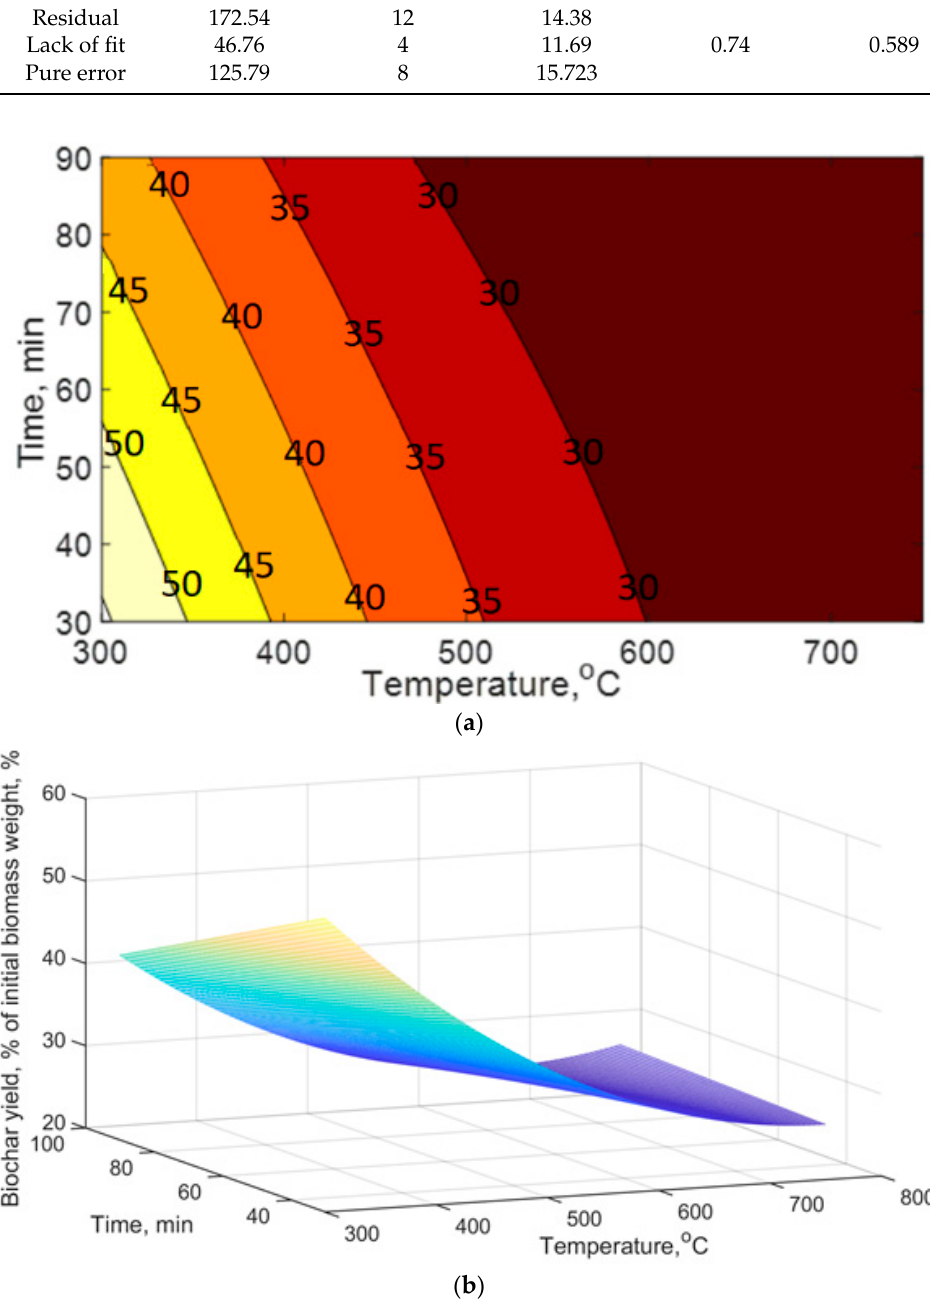
Figure 4. Contour ( a ) and surface ( b ) plots of biochar yield (% wet basis) at different temperatures and pyrolysis times. Table 4. ANOVA results for the reduced second-order polynomial model.